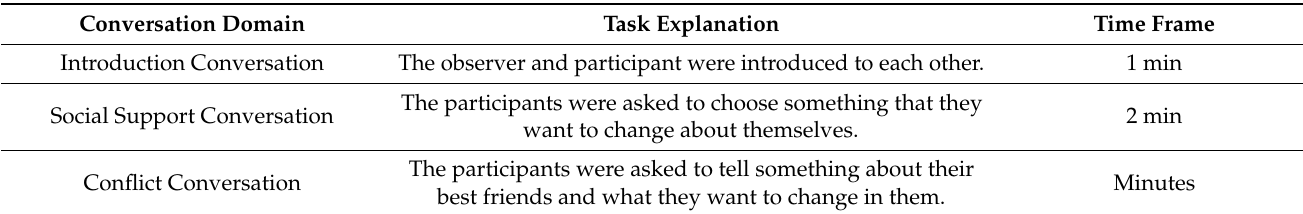
Table 3. The conversation contents and procedure. Conversation Domain Task